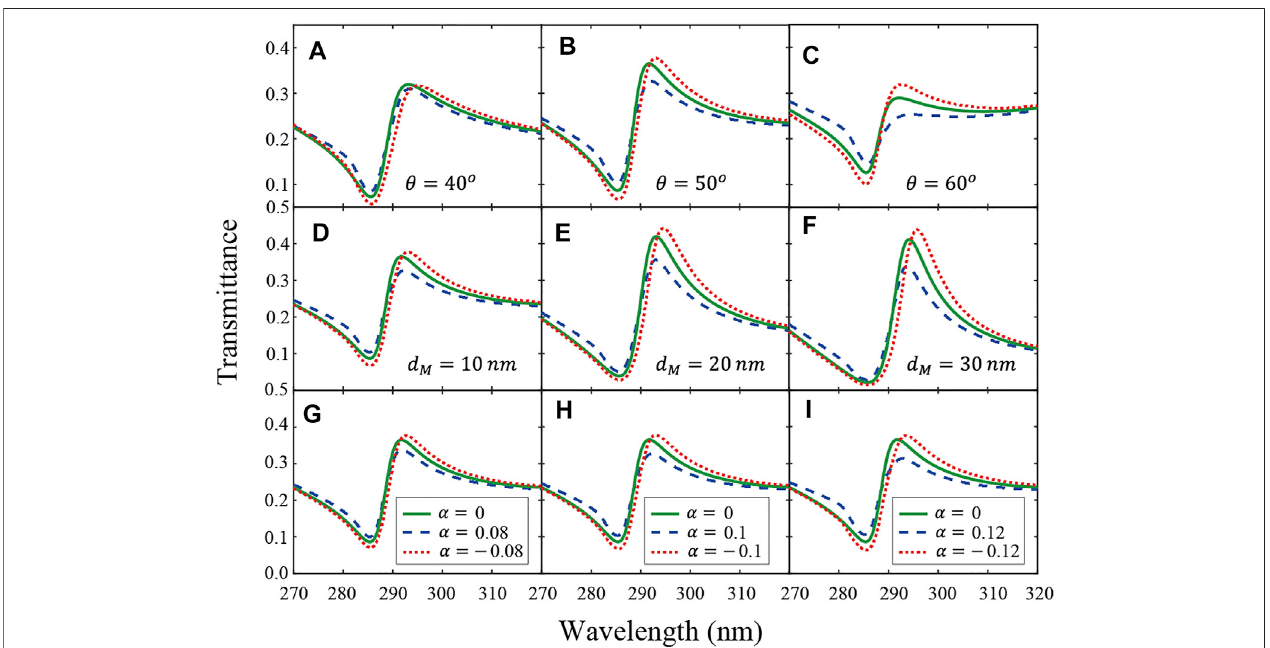
FIGURE3|(A) – (C) Transmittancespectrumofthecompositestructure M ( AB ) 3 fordifferentincidentangles: θ =40 ° (A) , θ =50 ° (B) ,and θ =60 ° (C) .Solidgreenline, dashed blueline,anddottedredlinedenotetheresultsforMOcoef fi cient: α =0, α =0.1,and α = − 0.1,respectively. (D – F) Similarto (A – C) ,butforthedifferentthickness oflayer M : d M =10 nm (D) , d M =20 nm (E) ,and d M =30 nm,respectively. (F) . (G – I) Similarto (A – C) ,butforthedifferentstrengthofMOcoef fi cient:| α |=0.08 (G) ,| α |= 0.10 (H) , and | α | = 0.12 (I) , respectively.